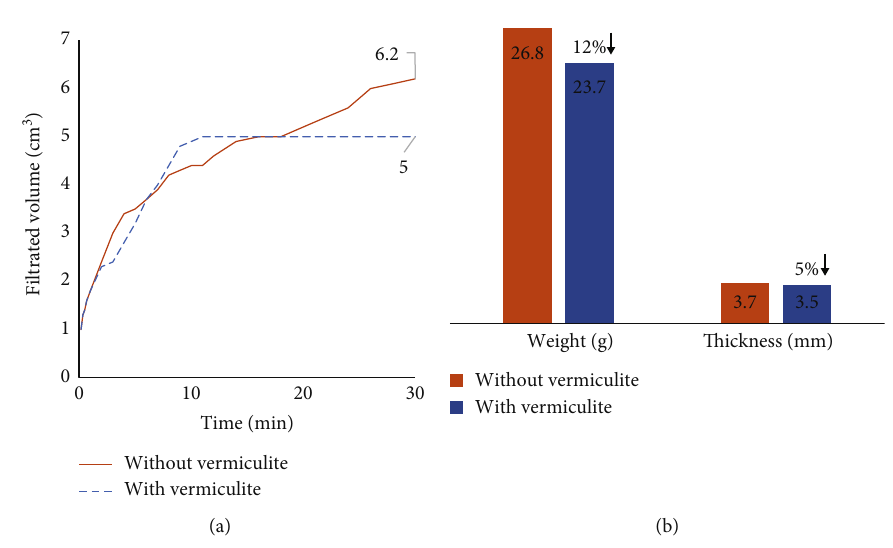
Figure 6: Results of oscillatory amplitude and frequency tests.